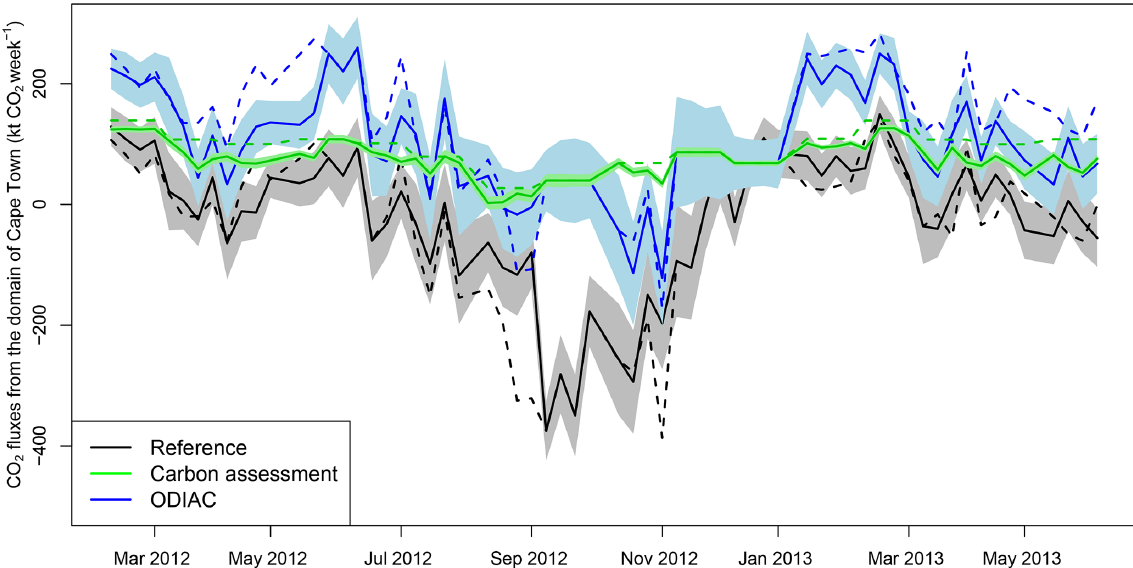
Figure 6. Prior and posterior aggregated weekly fluxes over the inversion domain from March 2012 to June 2013 for the reference, carbon assessment and ODIAC inversions. The dashed line represents prior flux estimates and the solid line represents posterior flux